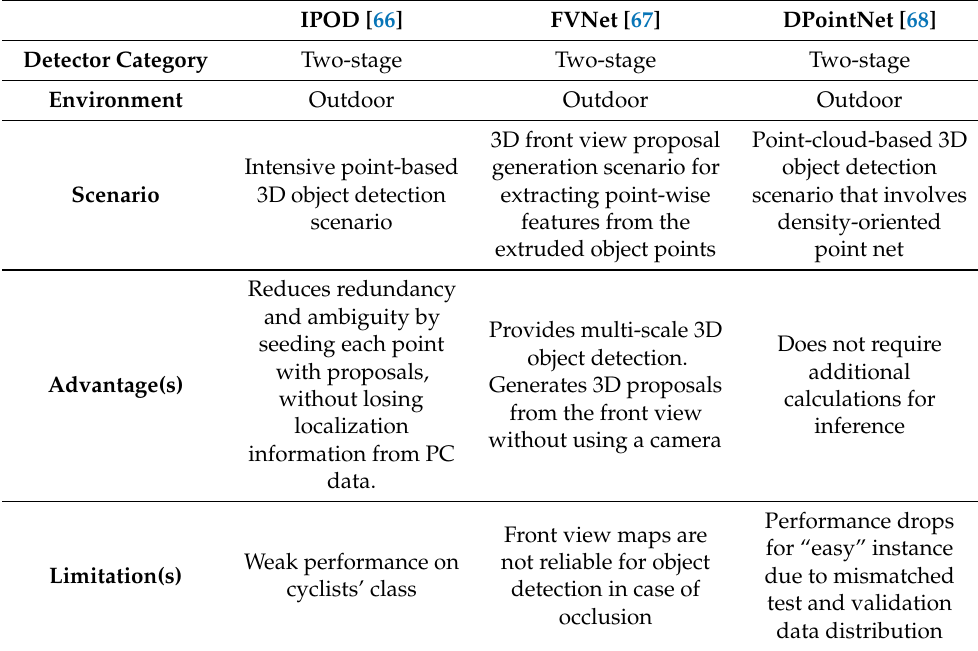
Table 14. Literature Analysis: PointNet-based 3DOR Methods.